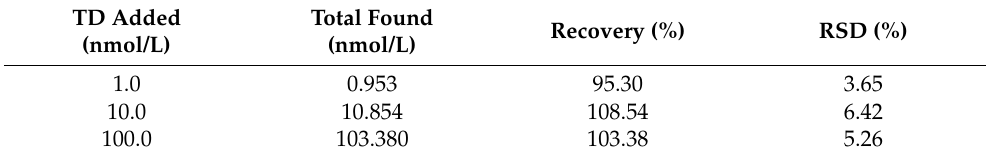
Table 3. Application of the biosensor to detect HPV-16 DNA in serum